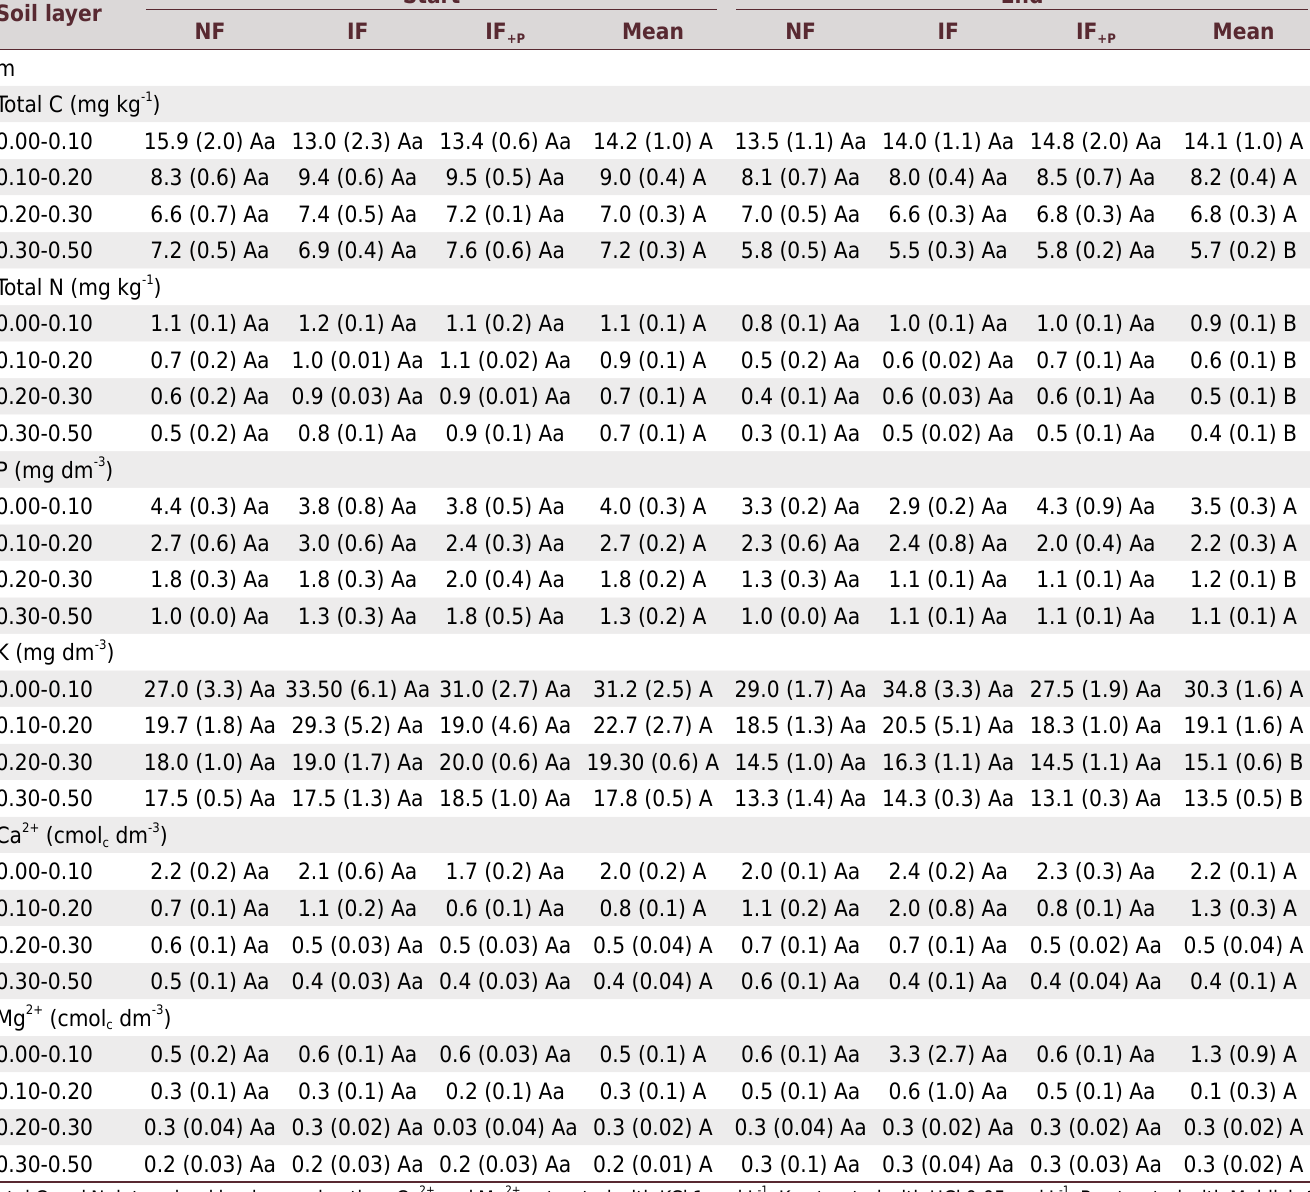
Table 2. Total carbon, total nitrogen, available phosphorus, potassium, calcium, and magnesium in soil at the start and at the end of 23 months of natural fallow (NF), improved fallow (IF), and improved fallow with P fertilization (IF +P ) in Marapanim, eastern Amazonia Soil